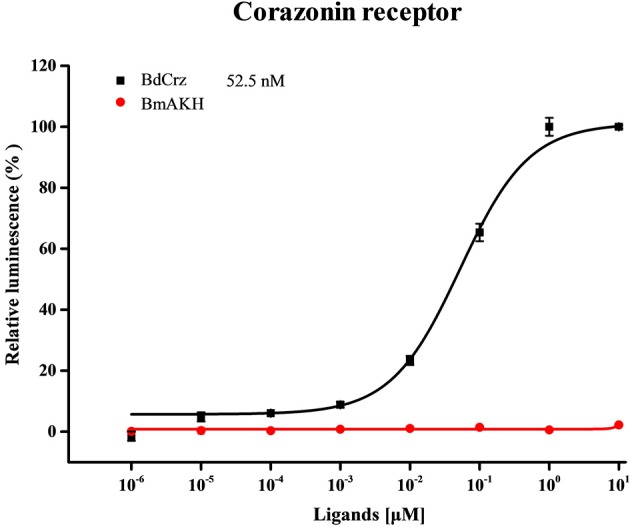
Concentration-response curves for Ca2+ responses in BdCrzR-expressing CHO cells. The sequences of peptides used in this graph are shown in Table 1. Data points represent the mean ± SE based on three independent measurements, each containing three replicates of the tested concentration series. All values were corrected for the negative control (nuclease-free water). The EC50 values are depicted with their corresponding 95% confidence interval.